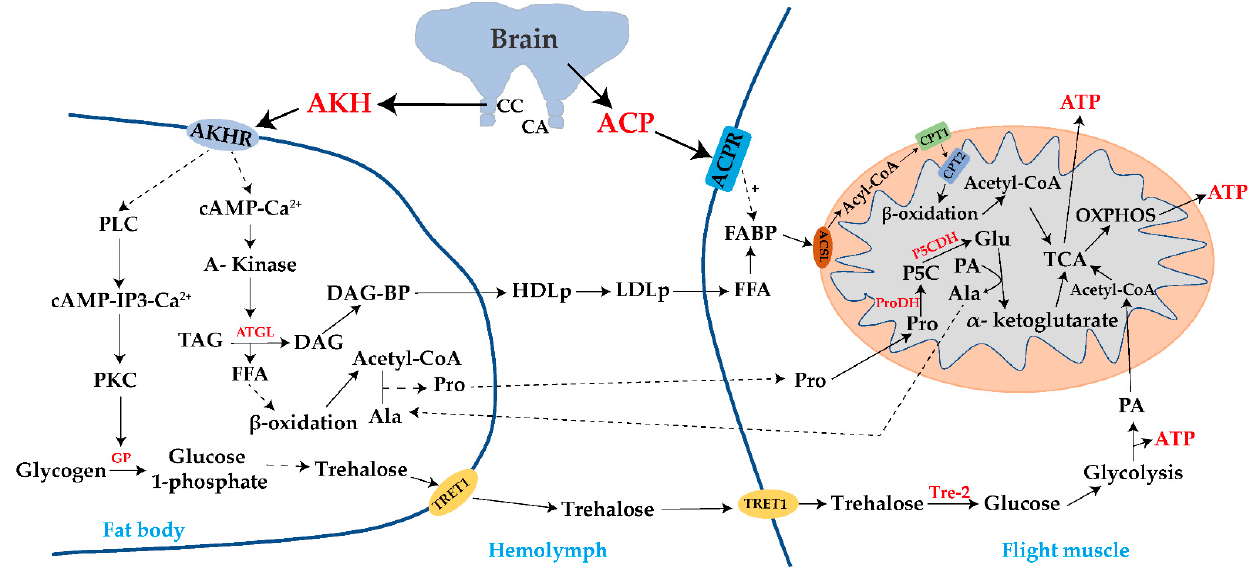
Figure 2. Metabolic regulation process of energy substances during insect migration flight. ACP: